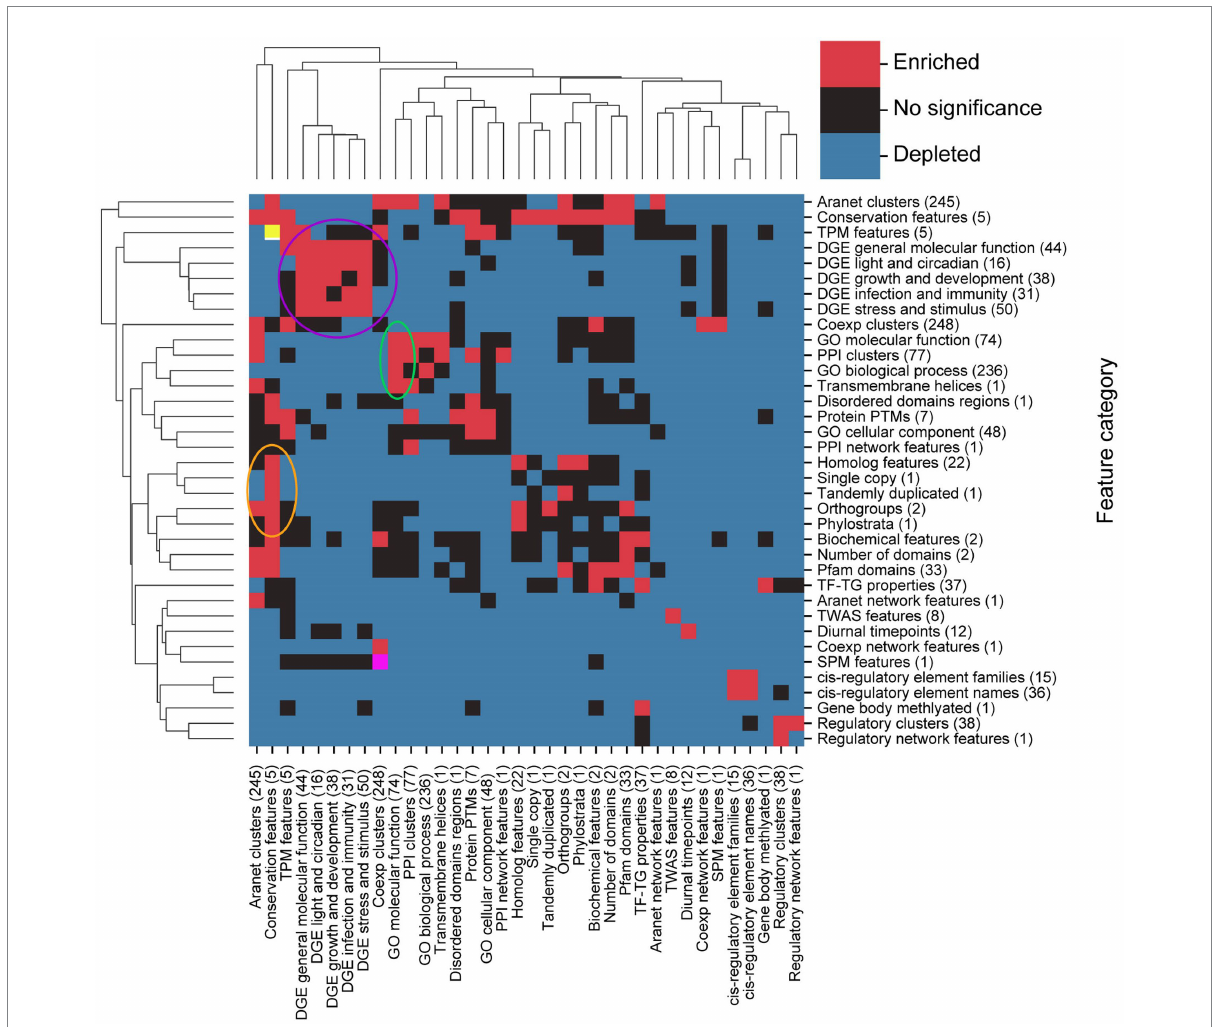
FIGURE 6 Identification of significantly associated feature types. The clustermap shows whether there are significantly (BH-adjusted values of p < 0.05) more (red squares) or significantly less (blue square) between feature categories that are expected by chance. Not statistically significant associations are indicated by black boxes. Circles indicate clusters of feature categories which are associated with each other. Yellow (top left) and pink (bottom left) squares are red squares which have been coloured differently to enable easy identification when our study refers to